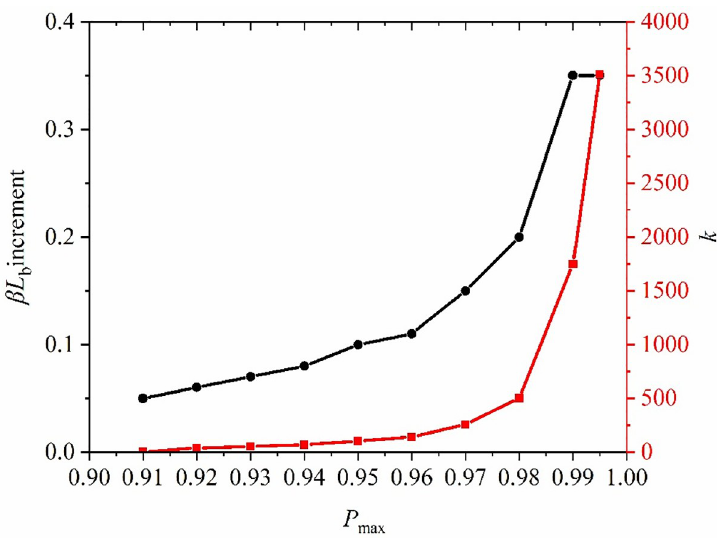
Fig 14. Changes of k and the increment of β L b along with the peak value of axial force.